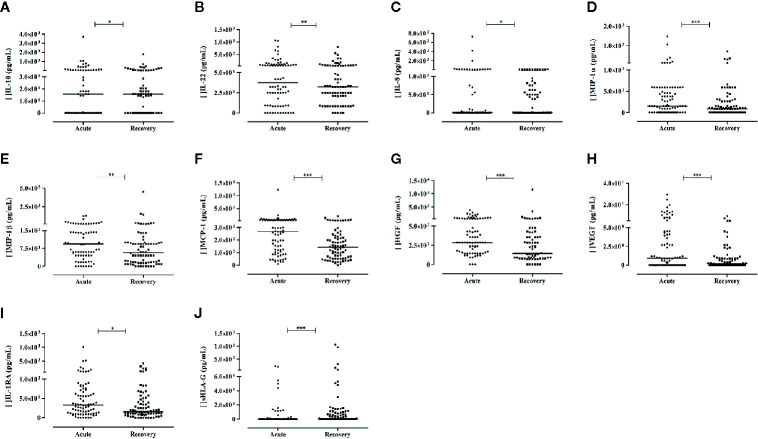
Soluble mediators exhibiting differential levels between acute phase and recovery phase of arbovirus patients presenting with neurological complications. Results from Wilcoxon Signed Rank Test. Cytokines: (A, B); chemokines: (C–F); growth factors: (G, H); cytokine receptor: (I); and sHLA-G: (J) P-values: *≤ 0.05; **< 0.01; ***< 0.0001. For (A–I), N = 80; for (J), N = 84.